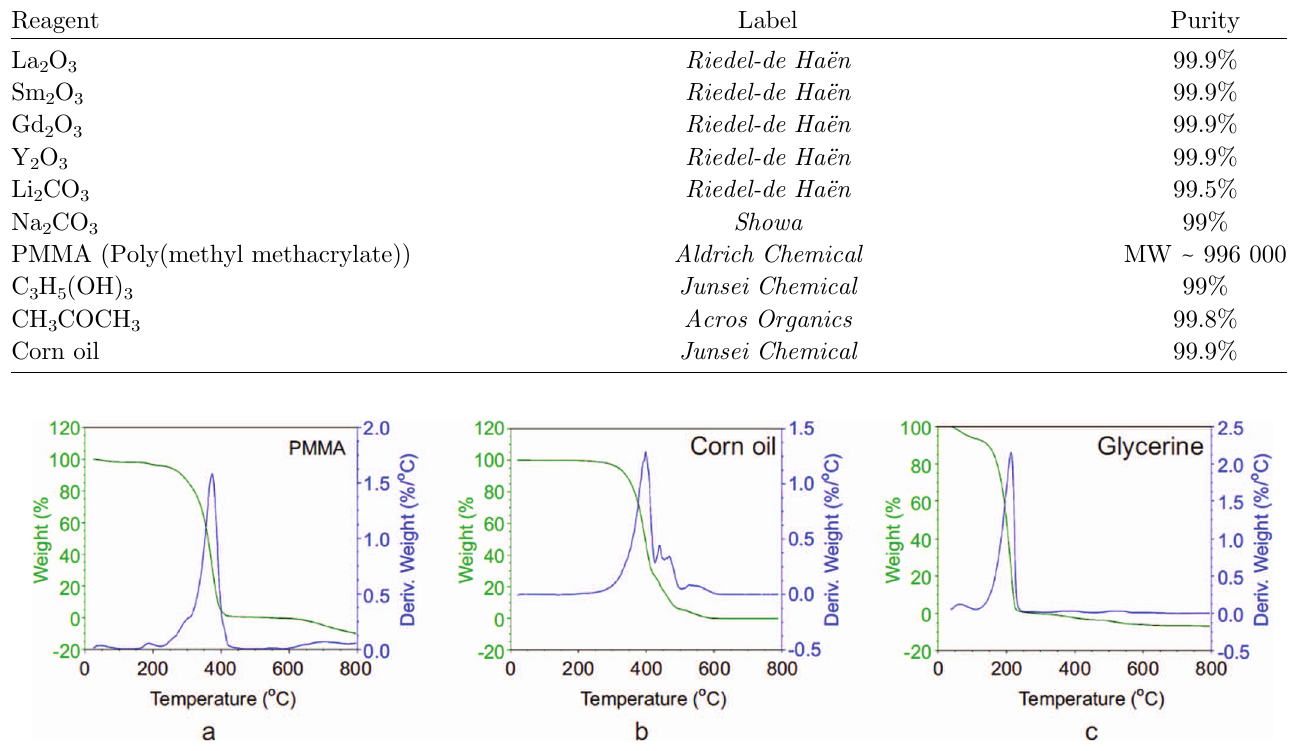
Fig. 1. TG/DTA diagrams of (a) binder (PMMA), (b) dispersant (corn oil), and (c) plasticizer